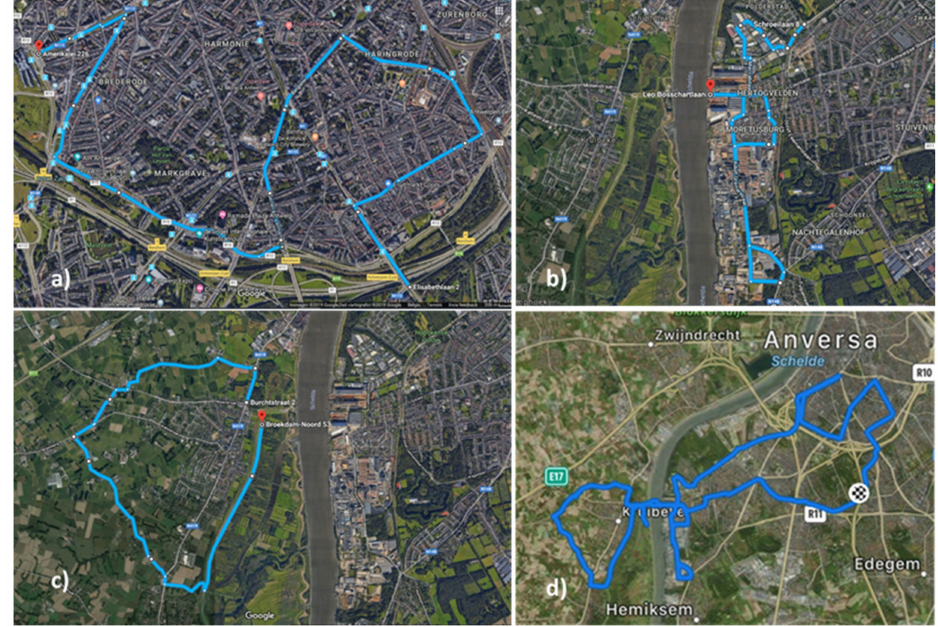
Figure 6. The four routes chosen in the city of Antwerp: ( a ) Urban route; ( b ) Industrial area; ( c ) Green zone; ( d ) Total